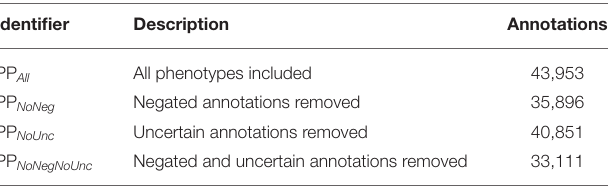
TABLE 2 | Summary of each set of patient phenotype profiles considered as an experimental setting.